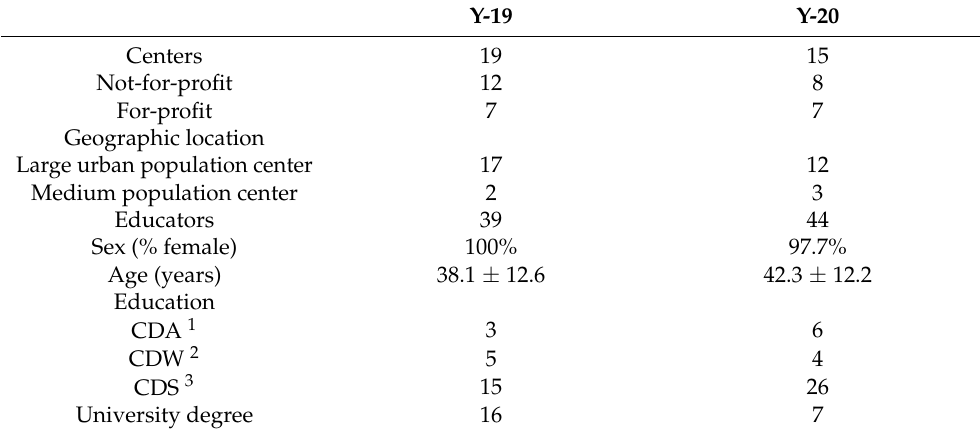
Table 1. ECEC center and educator characteristics before and during the COVID-19